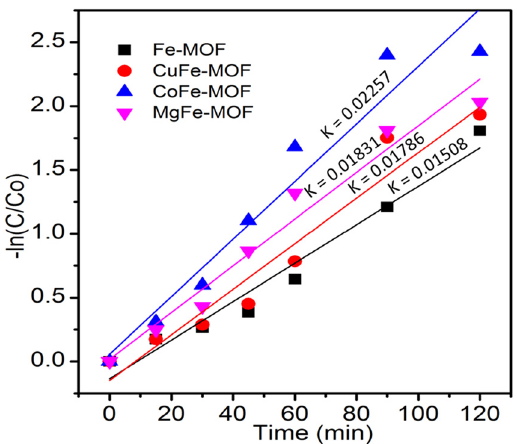
Figure 7: Kinetics study of photocatalytic RhB degradation using of M/Fe - MOF ( M = Co, Cu, and Mg )